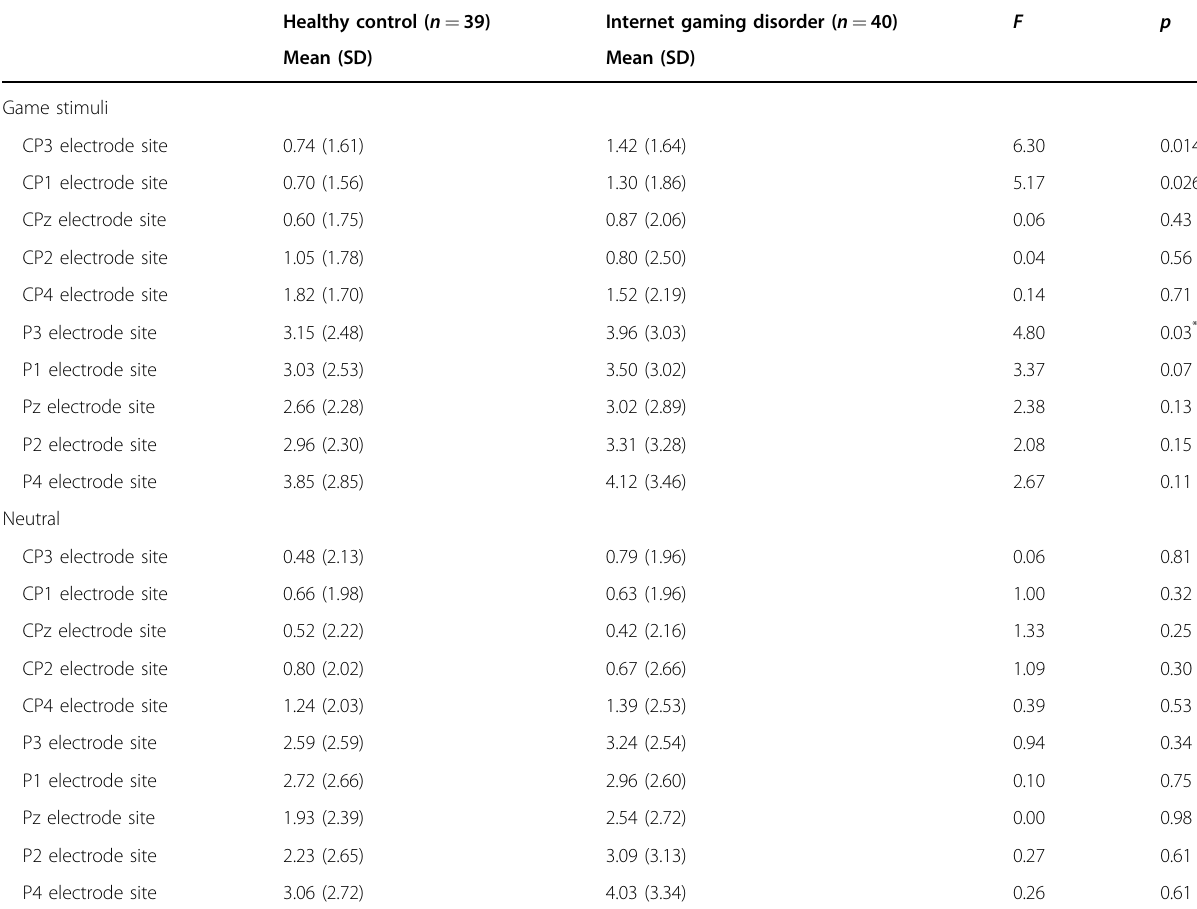
Table 2 Comparison of late positive potentials (LPPs) that averaged between 400 and 700 ms post-stimulus onset across the Internet gaming disorder and healthy control